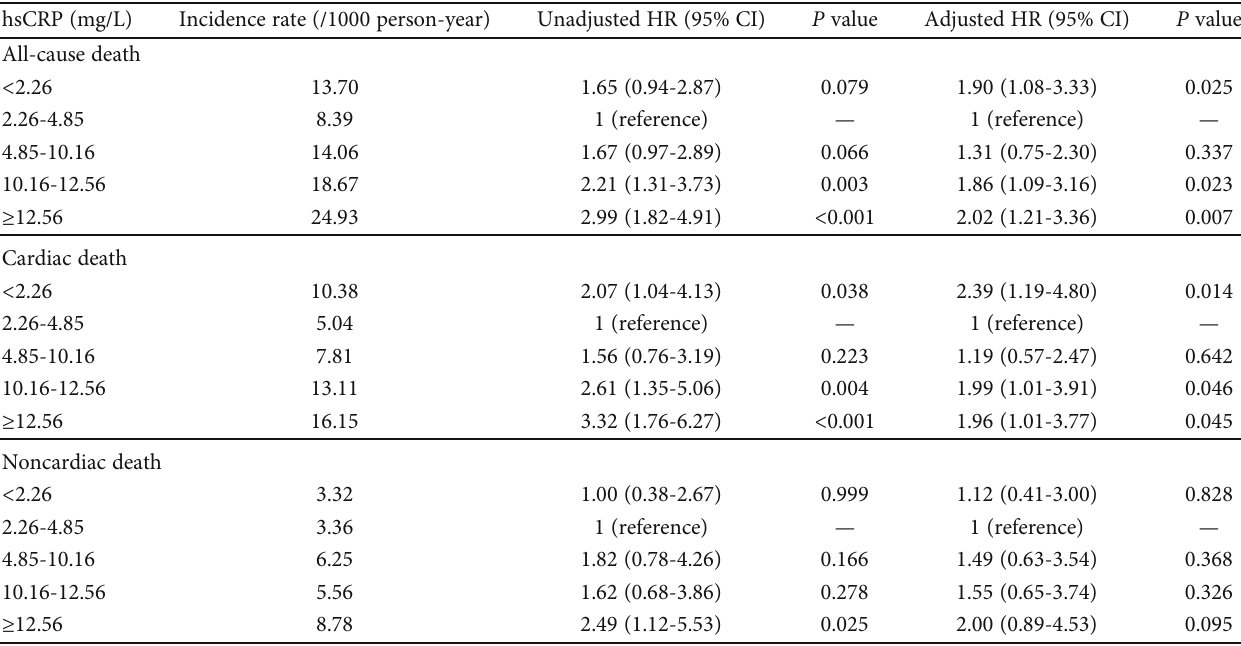
Table 3: Incidence rate and hazard ratio according to quintiles of postprocedural hsCRP for all-cause death, cardiac death, and noncardiac death. HR: hazard ratio; CI: con fi dence interval; hsCRP: high-sensitivity C-reactive protein. hsCRP (mg/L)